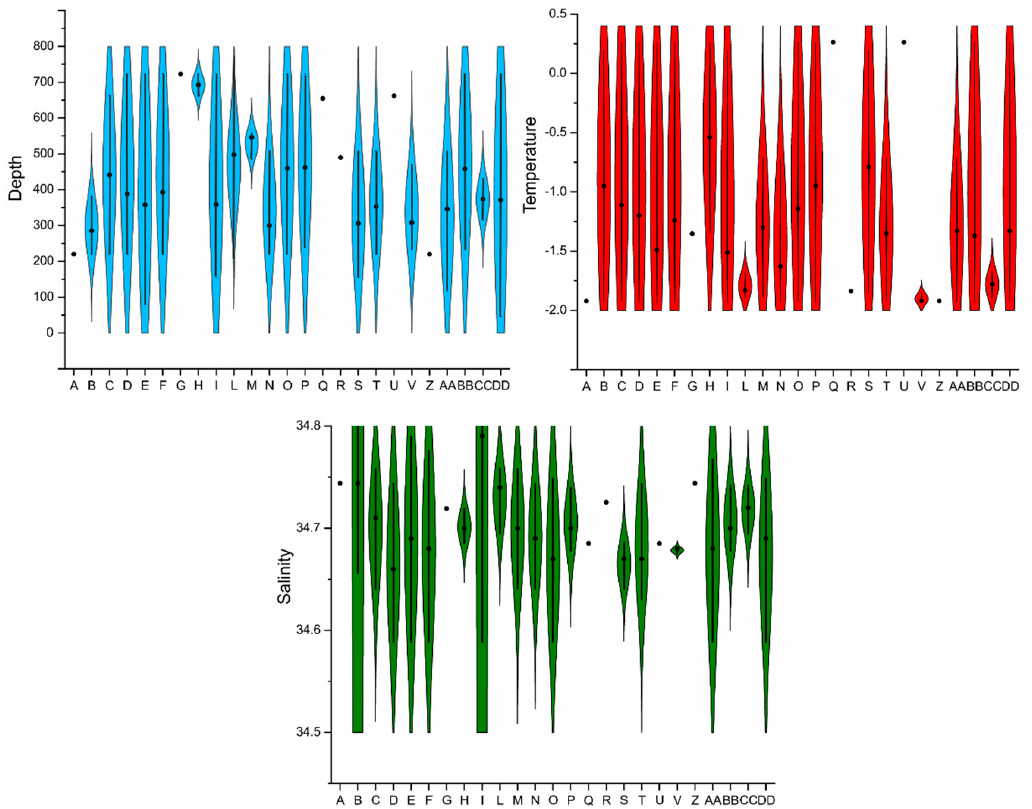
Figure 7. Violin box plots summarizing the values of depth, temperature and salinity ranges for the ostracod species recovered in the Western Ross Sea Shelf area. The thick dots within the box plots represent the median, and thick lines inside the box plots represent the upper and lower quartiles.